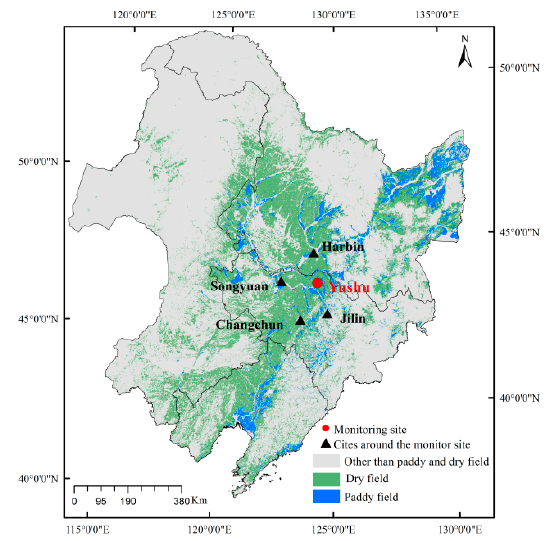
Figure 1. Geographical location of the monitoring site and major cities around the monitoring site in Northeast